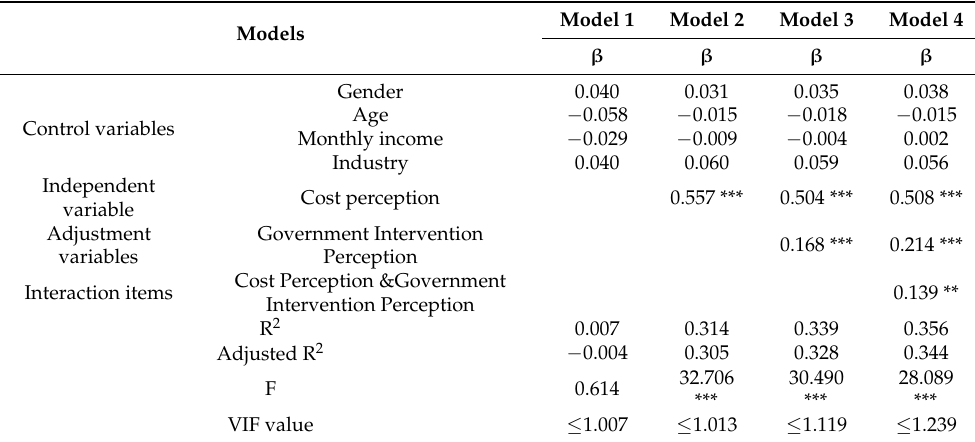
Table 15. Moderating role of perceived government involvement in cost perception and willingness to perform.